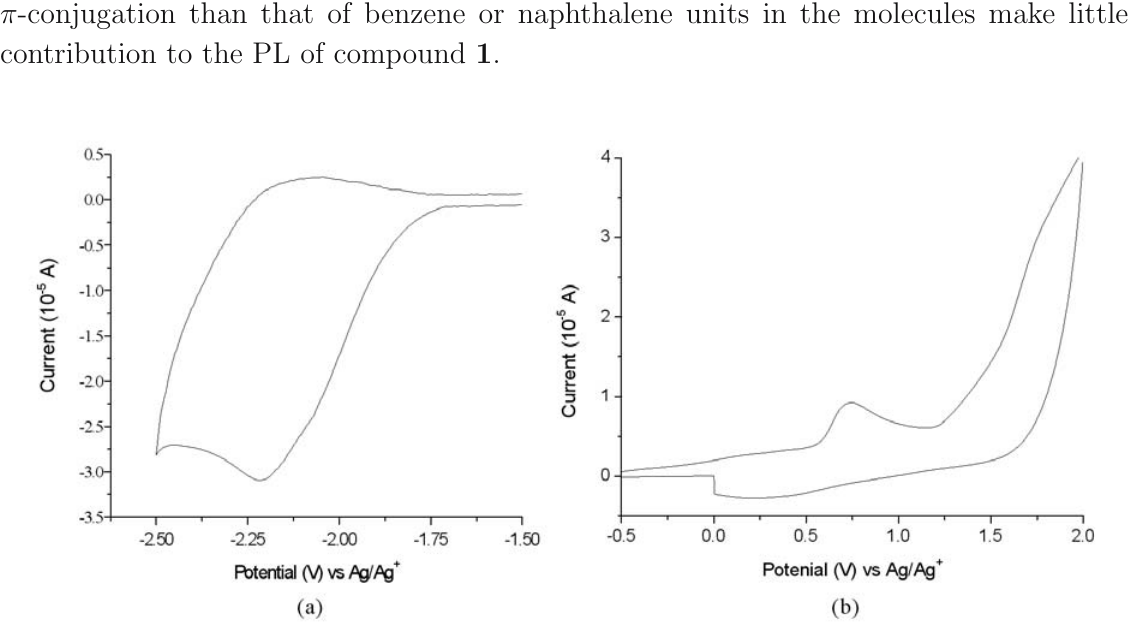
Fig. 3 The CV curves of compound 1 : (a) reduction and (b)